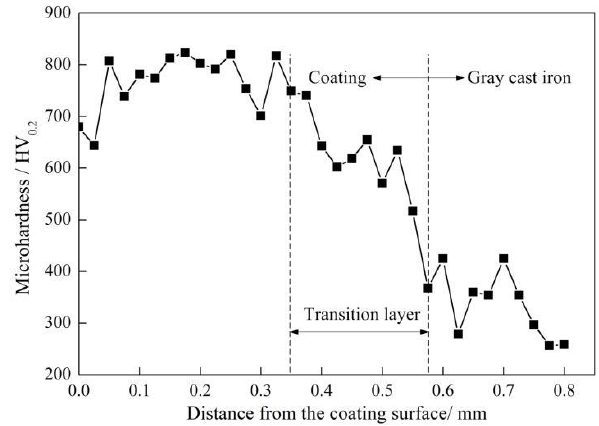
Figure 9. Microhardness distribution from Fe-based alloy coating to the gray cast iron substrate.